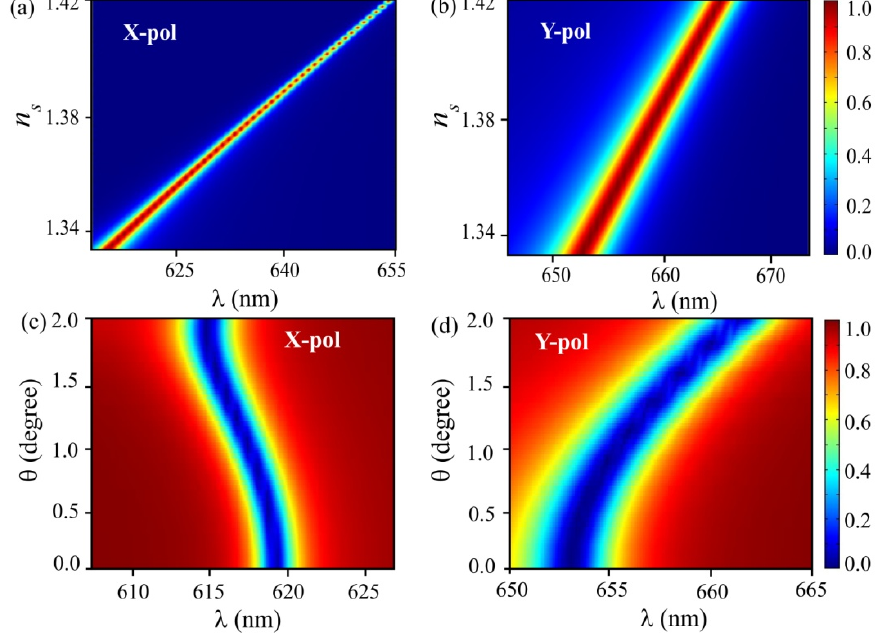
Figure 6. Contour plots for reflectivity and transmittivity: ( a , b ) show the reflectivity contour plots of different n s with λ for both the polarized lights. ( c , d ) show the transmittivity contour plots for different θ with λ for X-pol and Y-pol lights, respectively.